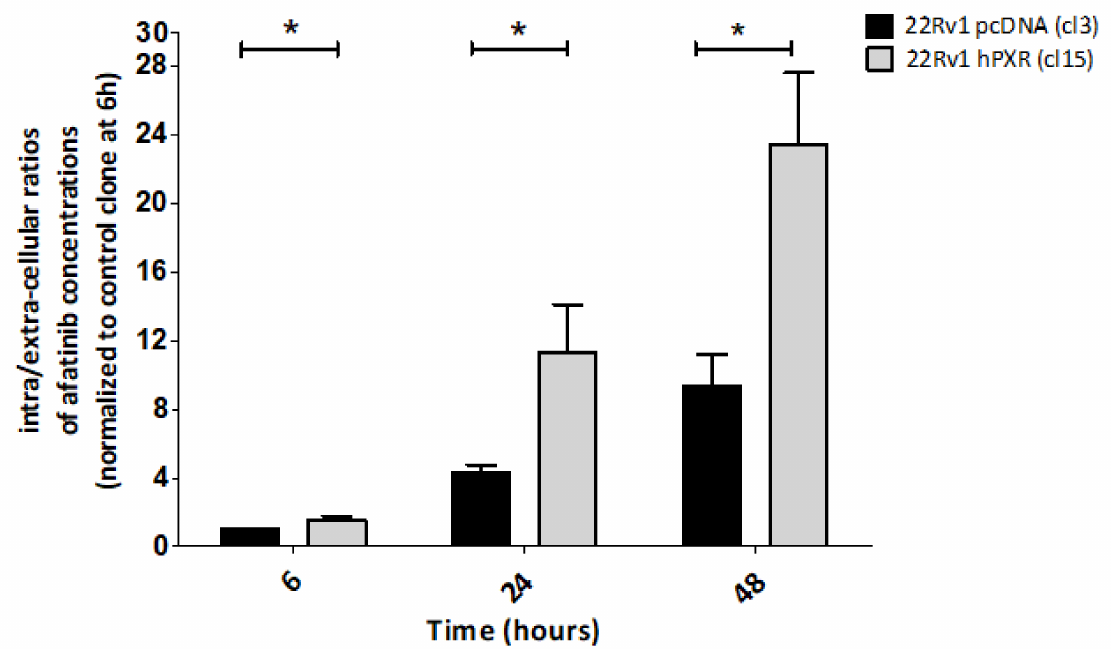
Figure 4. Effects of stable expression of PXR on the intracellular accumulation of afatinib. 22Rv1 cells stably expressing PXR (clone 15) and control cells (clone 3) were treated with 1 µ M afatinib for 6, 24, and 48 h and concentrations of afatinib were measured using mass spectrometry (see Materials and Methods section). Results are expressed as intracellular/extracellular ratios of drug concentrations normalized to control clone that was set at one for the 6 h time point and are the mean ± SEM of 3 independent experiments. (*) p < 0.05 as evaluated by Student’s t